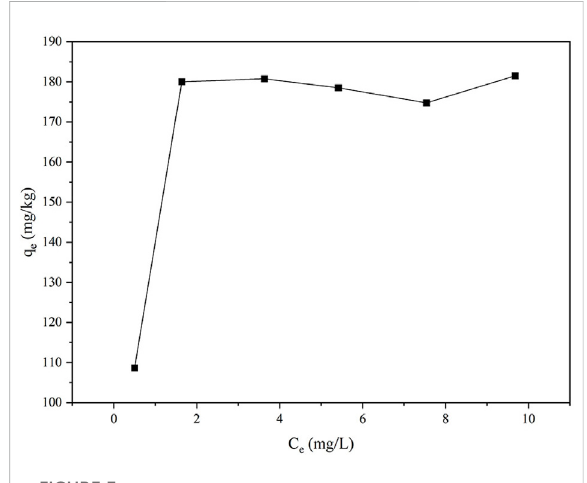
FIGURE 3 Adsorption isotherms of phosphorus on ceramsite loaded with